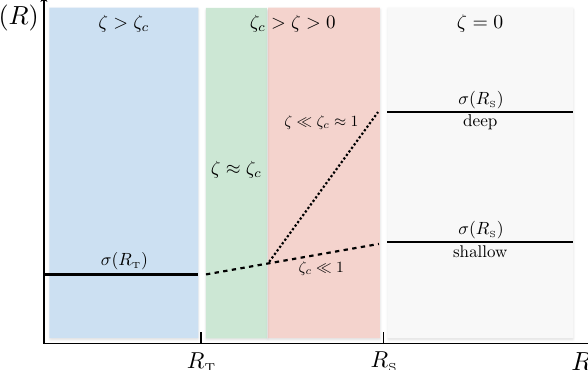
Figure 5: Sketch of the relevant regions of star for what concerns the bubble-wall tension. Dashed and dotted lines do not necessarily represent the functional form of σ ( R ) . In the green region the tension is dominated by the field displacement, while in the red region the barriers come to dominate. Note that for ζ minimum), there is in fact no red